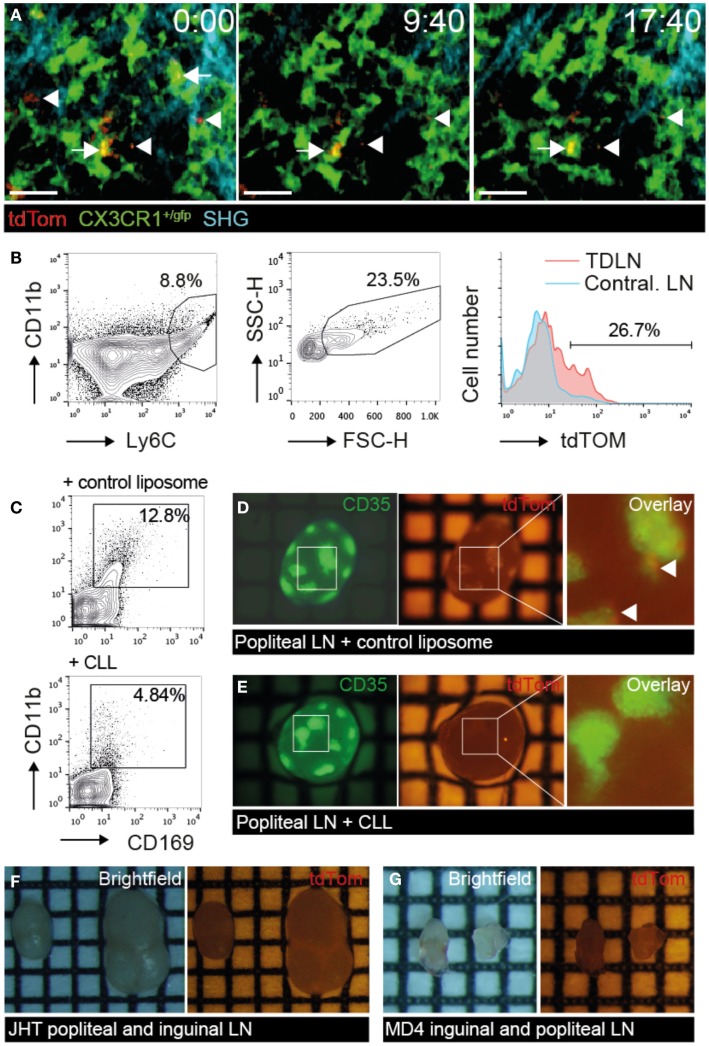
tdTom+ particle capture by SCS macrophages correlates with TDA deposition on FDCs. B16.F10-tdTom+ cells were s.c. injected into CX3CR1+/gfp, JHT or MD4 mice for 2PM and stereomicroscopy analysis. (A) 2PM image sequence of CX3CR1+/gfp macrophages associating with subcellular-sized tdTom+ particles (arrows) in TDLN SCS on day 9 after tumor injection. Free tdTom+ particles are marked with an arrowhead. SHG, second harmonic generation image of collagen fibers in capsule. Scale bar, 20 μm; time in minutes and seconds. (B) Flow cytometry of CD11b+ Ly6C+ FCShigh macrophages for tdTom signal in TDLN and contralateral LN. (C) Representative flow cytometry analysis of popliteal TDLNs after control liposome or CLL treatment. (D) Representative green (left) and red (right) fluorescent image of primary TDLN (popliteal LN) in control liposome-treated mice on day 15 post tumor injection. Arrowheads in the overlay (right) point to tdTom+ signals. (E) Representative green (left) and red (right) fluorescent image of primary TDLN (popliteal LN) in CLL-treated mice. (F) Representative brightfield (left), and red fluorescent (right) image of popliteal and inguinal TDLN in B cell-deficient JHT mice. (G) Representative brightfield (left), and red fluorescent (right) image of inguinal and popliteal TDLN in MD4 mice. Each square in F represents 1 mm2. Data in (A) are representative of four mice in two independent experiments, while B is showing results of one of two mice. Data in (C–G) are representative of 3 CLL- and 2 control liposome-treated C57BL/6 mice in one experiment, and 7 JHT and 5 MD4 mice in 2 independent experiments on days 15 and 30 post tumor injection.